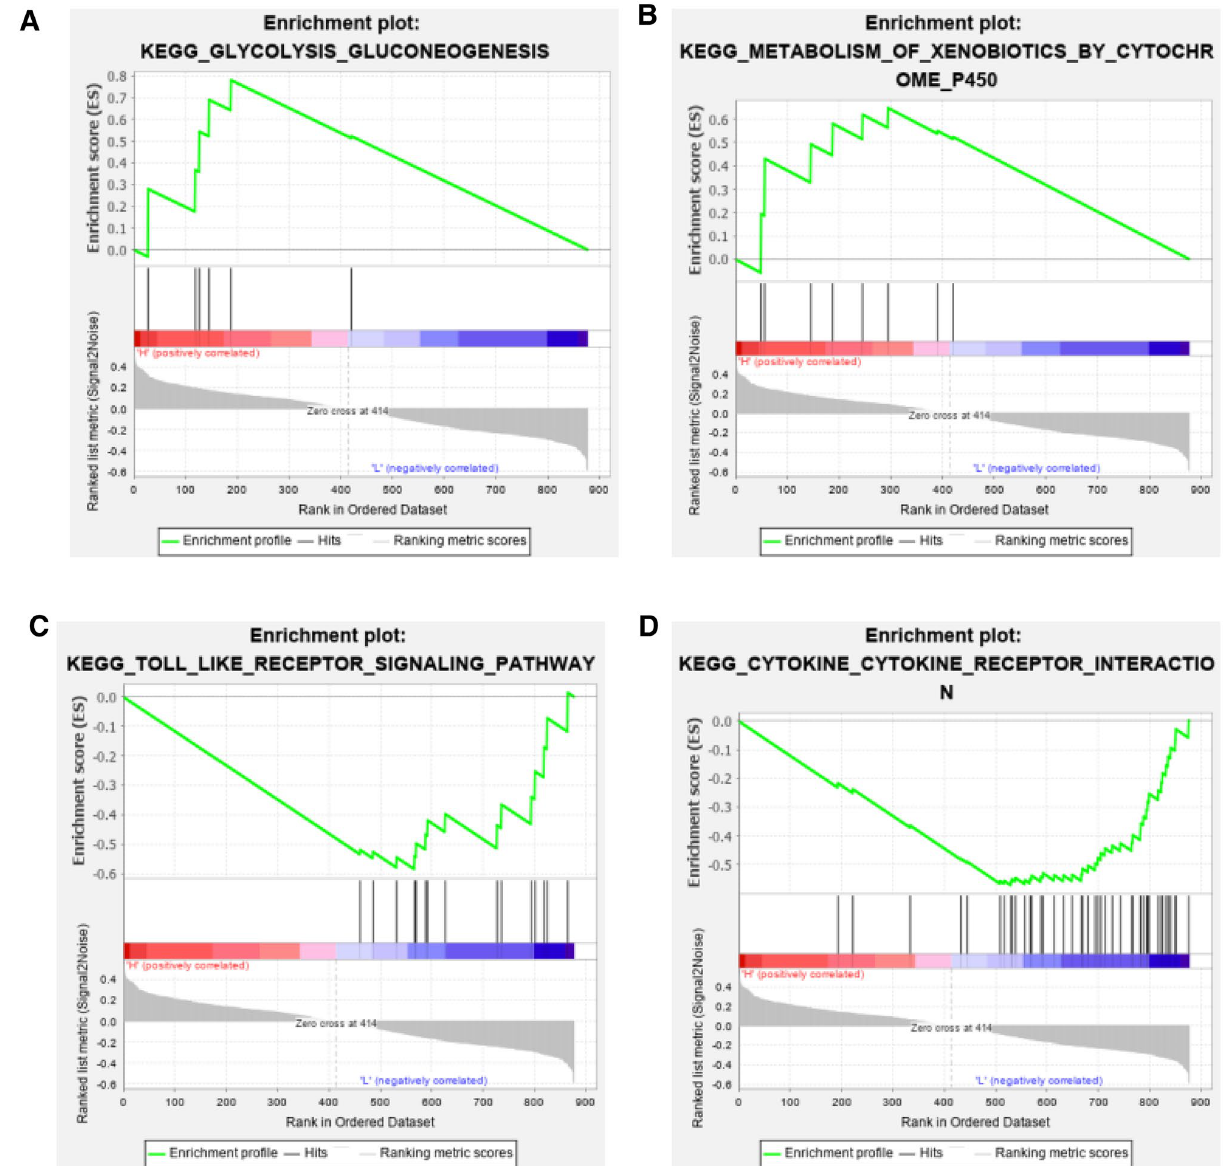
Figure 4. GSEA analysis results. ( A , B ) The signal pathway enriched in PXR high expression groups. ( C , D ) The signal pathway enriched in PXR low expression